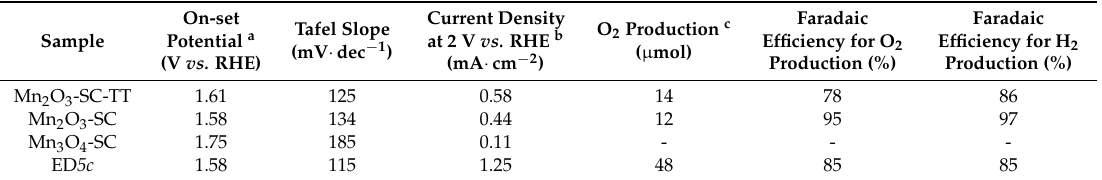
Table 1. Catalytic properties of the MnO x films prepared by different methods.